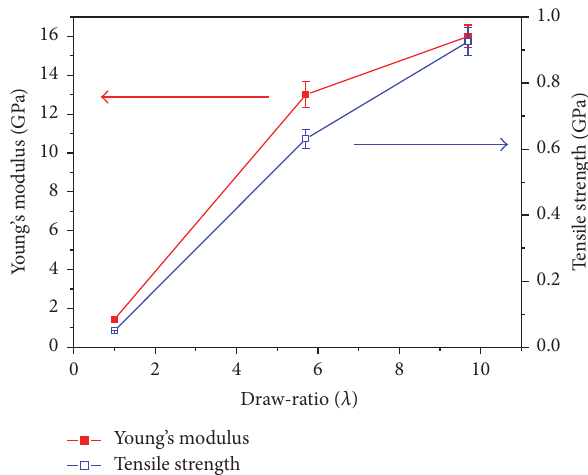
Figure 5: Mechanical properties of as-spun PET bristle ( 𝜆 = 1 ), solid-statedrawnPETafterthefirstdraw( 𝜆 = 5.7 ),andseconddraw ( 𝜆 = 9.7 ), respectively.